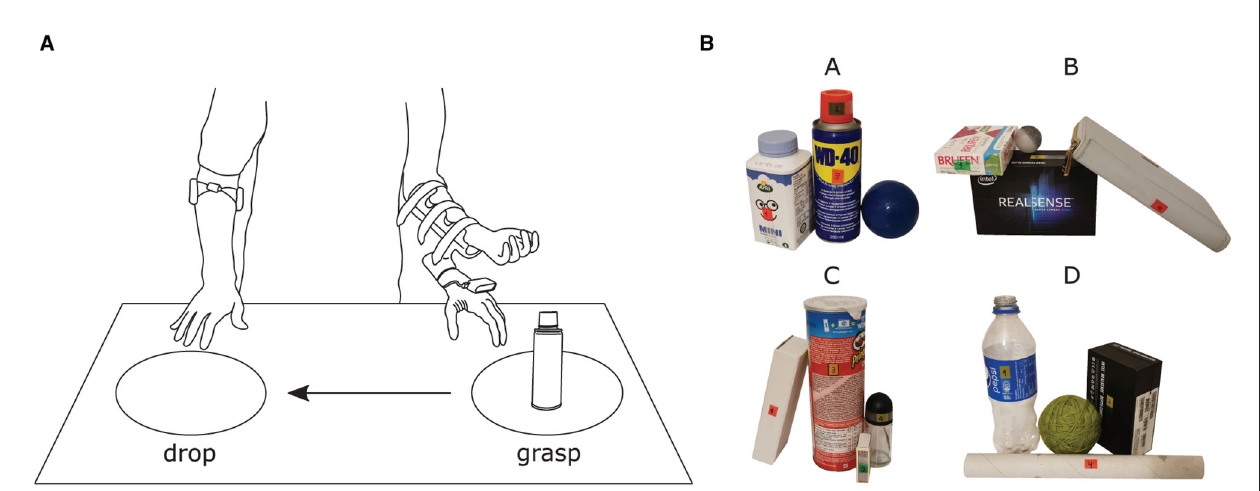
FIGURE 4 | (A) Illustration of the experimental environment comprising a table where two marked areas, separated by a distance of 50 cm, defined the positions for grasping and dropping objects. (B) All 16 objects organized in four different cluttered scenes (A, B, C, and D). Six new objects were introduced in Phase II and no training was provided for them. The labels placed on each object were used as cues to indicate from where the object should be approached and they also provided the number regarding the grasping order.